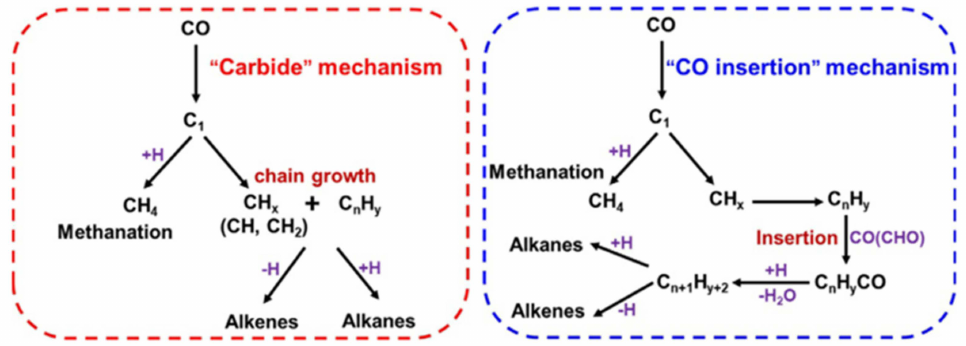
Figure 21. Schematic illustration of the “carbide” and “CO insertion” mechanisms proposed in CO-FTS for hydrocarbon synthesis. Reprinted with permission from Nie et al. [20]. Copyright (2019) published Elsevier. Reprinted with permission from van Santen et al. [158]. Copyright (2013) The Royal Society of